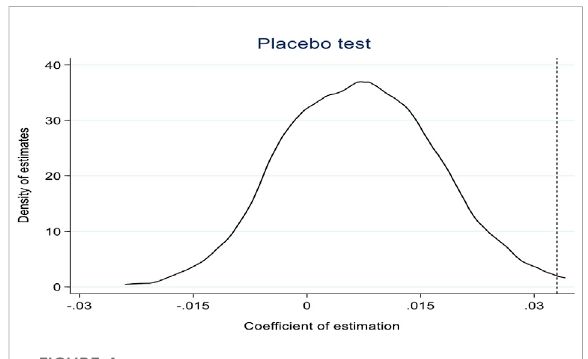
FIGURE 4 The estimated coef fi cients of randomly assigned treatment groups.